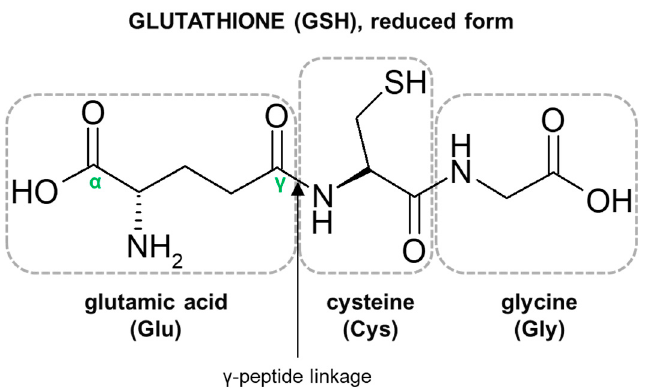
Figure 1. Structure of the tripeptide glutathione (GSH). Glutamic acid (Glu) is linked in a γ -peptide linkage (via its γ -carboxyl group) to cysteine (Cys), which in turn forms an α -peptide linkage with glycine (Gly).